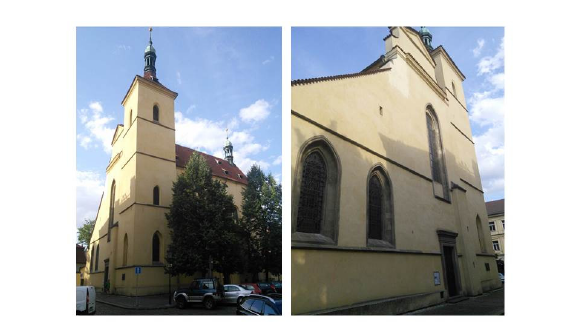
Figure 8. St. Haštal church